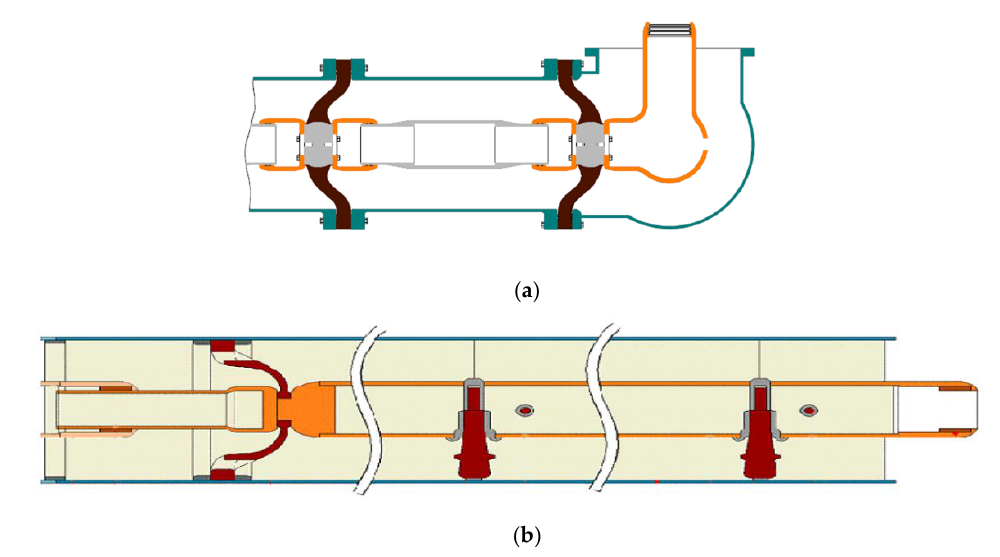
Figure 1. Type of insulators. ( a ) Gas-tight conical insulators of a GIS busbar section (dark brown). ( b ) Post-type and non-gas tight conical insulators (brown) of a straight welded construction of GIL [30]. Spacers are cast, filled epoxy matrix with alumina (Al 2 O 3 ), or silica (SiO 2 ). The epoxy matrix